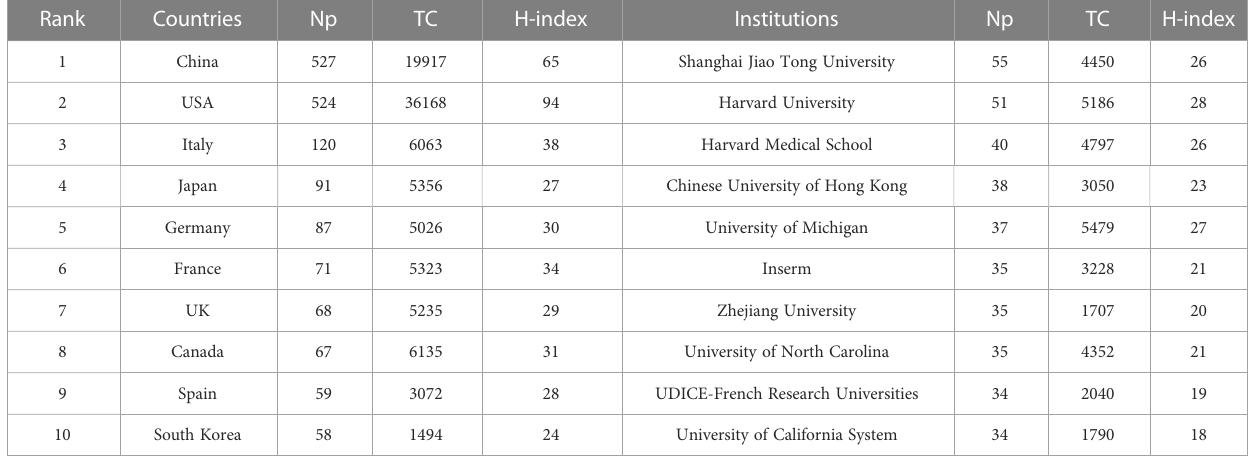
TABLE 4 The top 10 productive countries and institutions in IM/CRC.